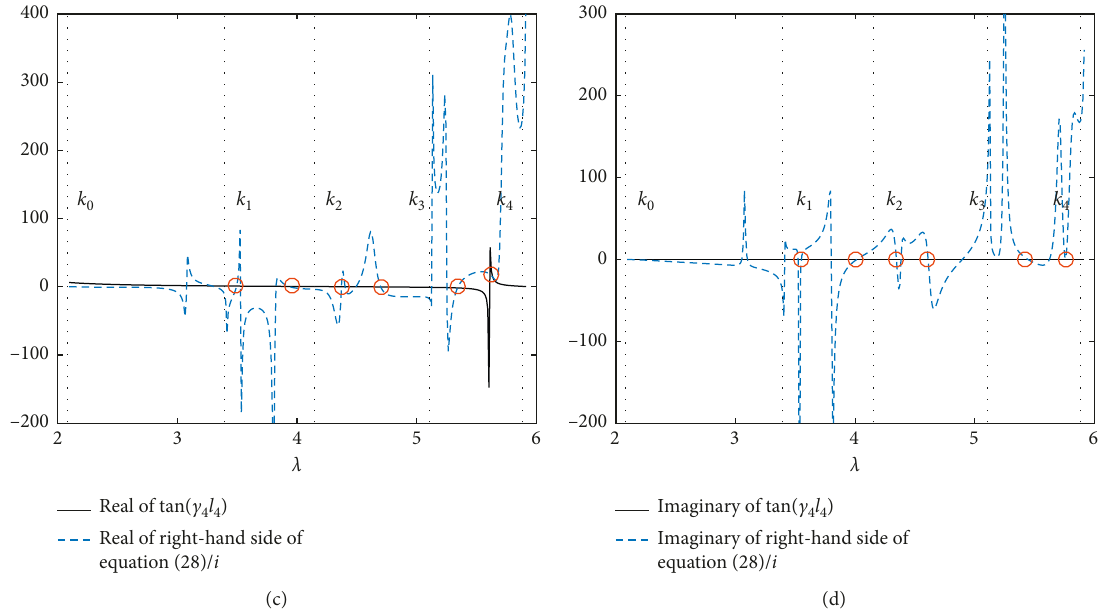
Figure 6: Graphical approach for root finding in evaluations of poles by (33) for the electromagnetic field due to a vertical dipole over a perfect conductor coated by four-layered lossless dielectrics, with (a) k i l i � 0 . 45 π ; (b) k i l i � 0 . 45 π ; (c) k i l i � 1 . 45 π ; and (d) k i l i � 1 . 45 π .